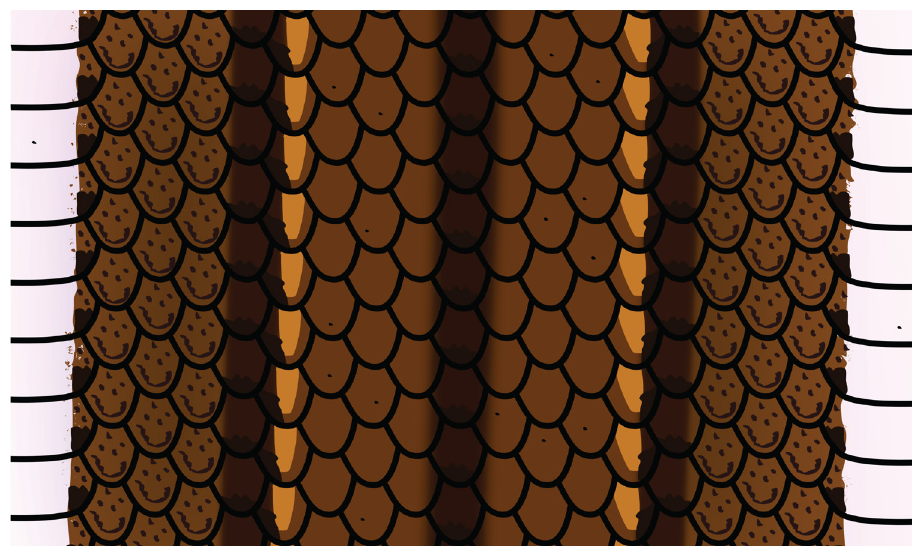
Figure 4. Diagram of coloration at level of midbody in Rhadinaea nuchalis sp. n. Based on holotype (MZFC-HE 22161). Nuchal blotches brownish orange; separated dorsally by median dark line; one dorsal scale long dorsally, widening laterally to two dorsal scales; nearly immaculate dorsally, with abundant dark speckling at level of supralabials; connected to pale